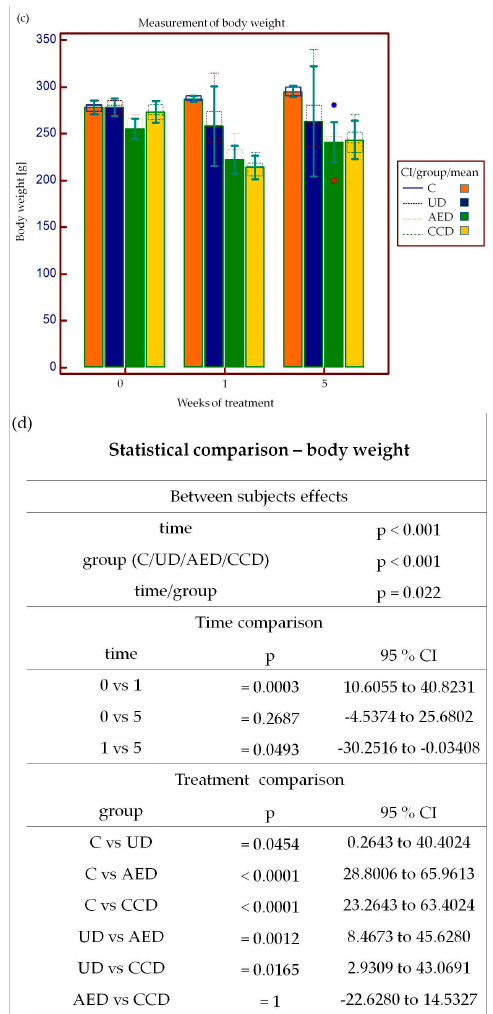
Figure 3. Effect of A. eupatoria and C. cardunculus water extracts on plasma glucose levels ( a ) and body weight in rats ( c ). Statistical comparison of the glucose levels ( b ) and body weight ( d ) between individual groups (CI—95% confidential interval, C—control group, UD—untreated diabetic